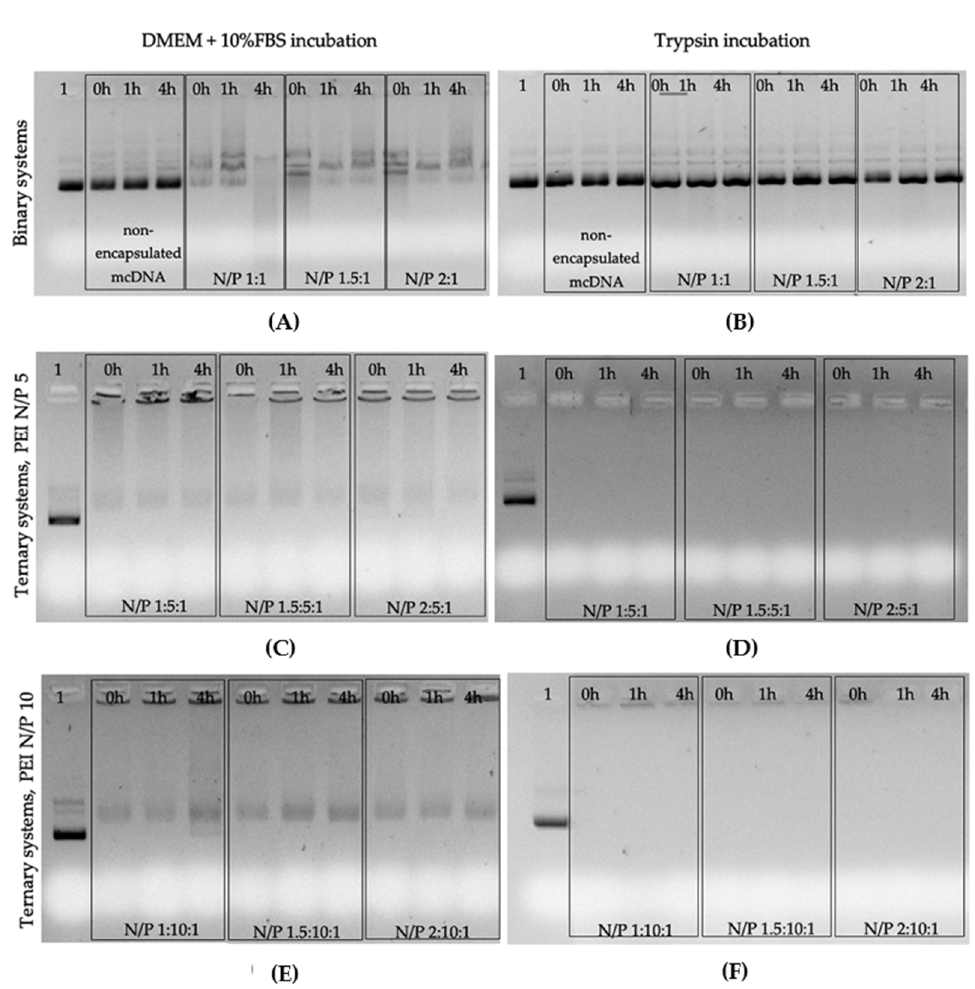
Figure 6. Electrophoretic analysis of mcDNA formulations after incubation with DMEM + 10% FBS ( A , C , E ) and with trypsin ( B , D , F ): 1- mcDNA control; A and B: R8-mannose/mcDNA-E7; C and D: R8-mannose/PEI/mcDNA-E7 systems formulated by maintaining a PEI N/P ratio of 5 and changing R8 N/P ratios; E and F: R8-mannose /PEI/mcDNA-E7 systems formulated by maintaining PEI N/P ratio of 10 and changing R8 N/P ratios.